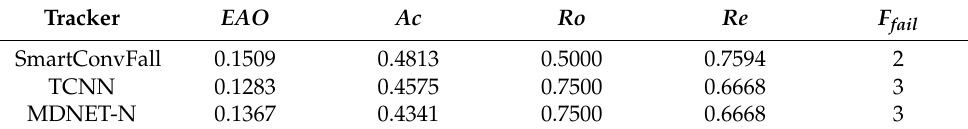
Table 14. Performance comparison of all tested trackers for the cluttered background attribute.